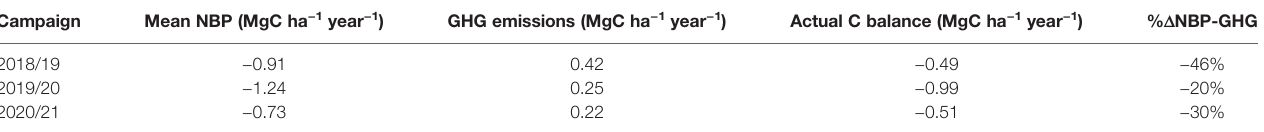
TABLE 5 | Carbon footprint estimates for the three agricultural campaigns for the Inland Pampa croplands, taking into account main crops. Campaign